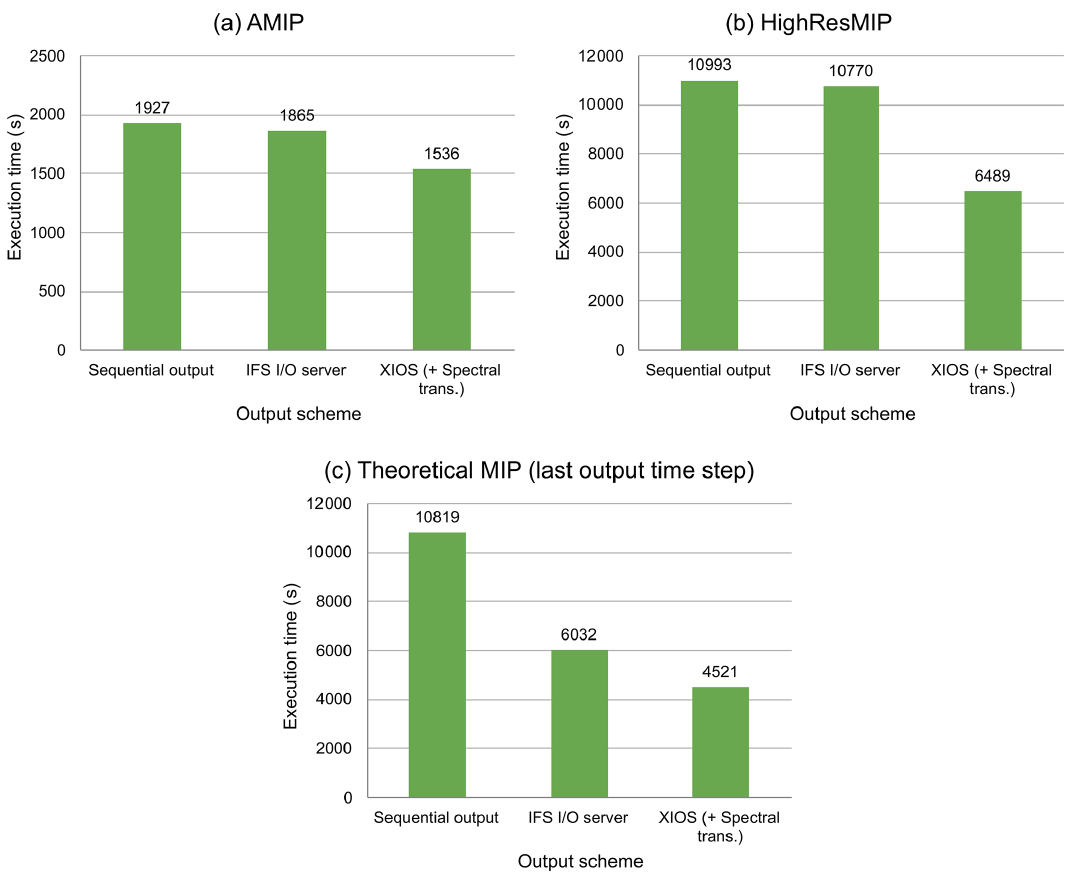
Figure 7. Comparison of the execution time of different output schemes for the three configurations evaluated: both sequential output and the IFS I/O server have the additional cost of transforming spectral fields and converting GRIB files to NetCDF